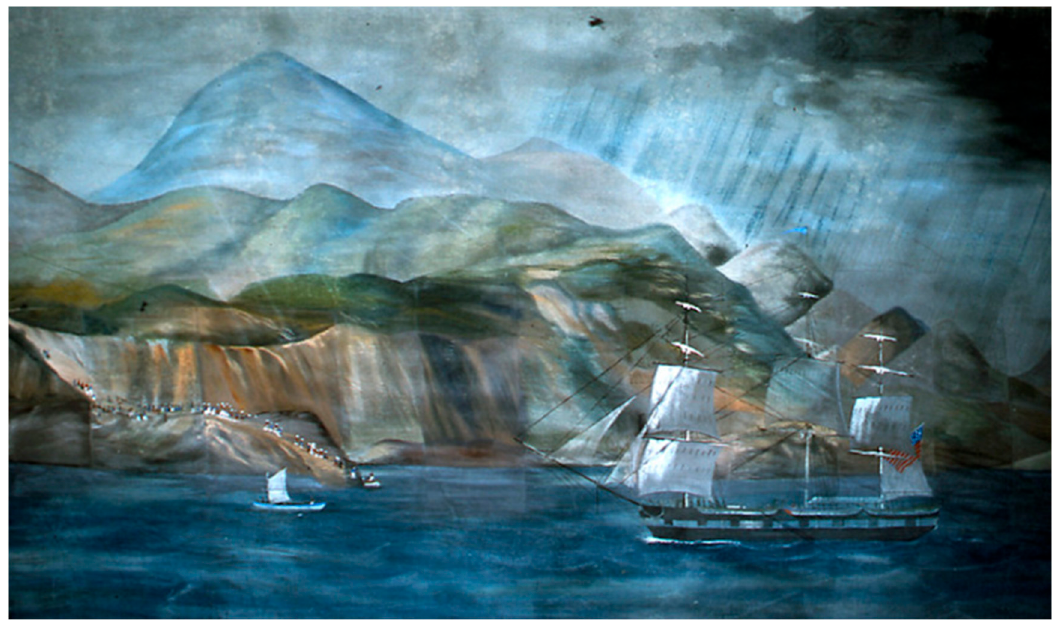
Figure 4. Island of Brava in the Grand Panorama of a Whaling Voyage Round the World by Caleb Purrington and Benjamín Russell, 1847–1848. Courtesy of the New Bedford Whaling Museum.